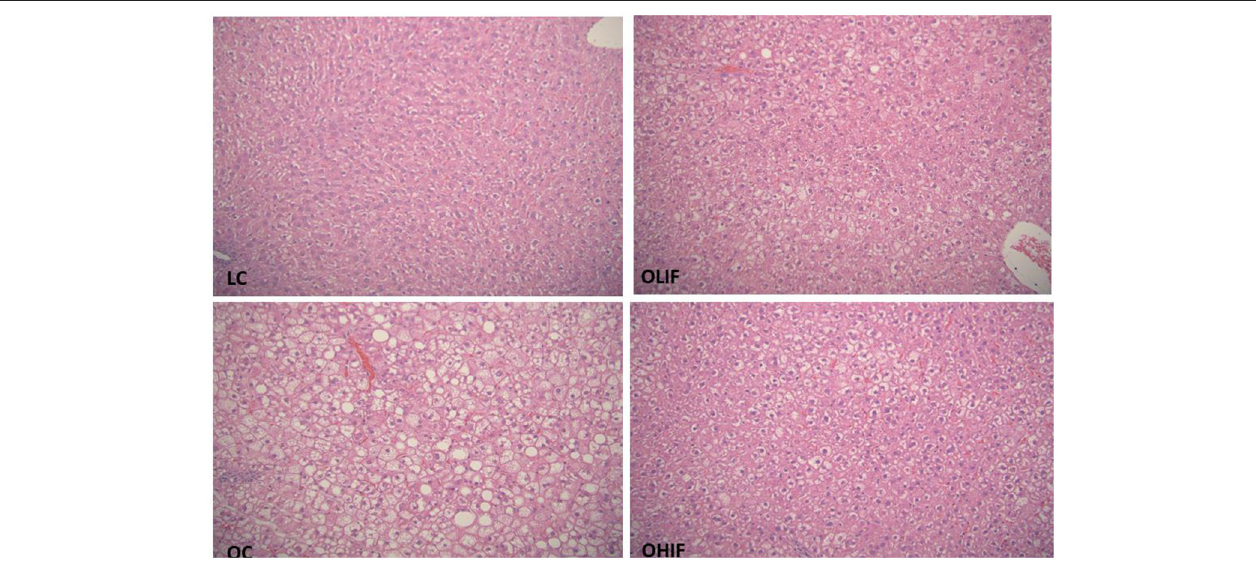
FIGURE 2 | Liver Steatosis in LC, lean control; OC, obese control; OLIF, obese low isoflavones; OHIF, obese high isoflavones fed rats. LC image shows morphologic features of one of lean sample, there is no evidence of steatosis in any lean samples. OC image shows marked micro and macrovasicular steatosis present essentially in all three zones. OLIF image shows predominantly microvasicular steatosis, predominantly around portal zone. OHIF image shows predominantly microvasicular steatosis, predominantly around portal zone. All images are original at 20 x magnifying power.